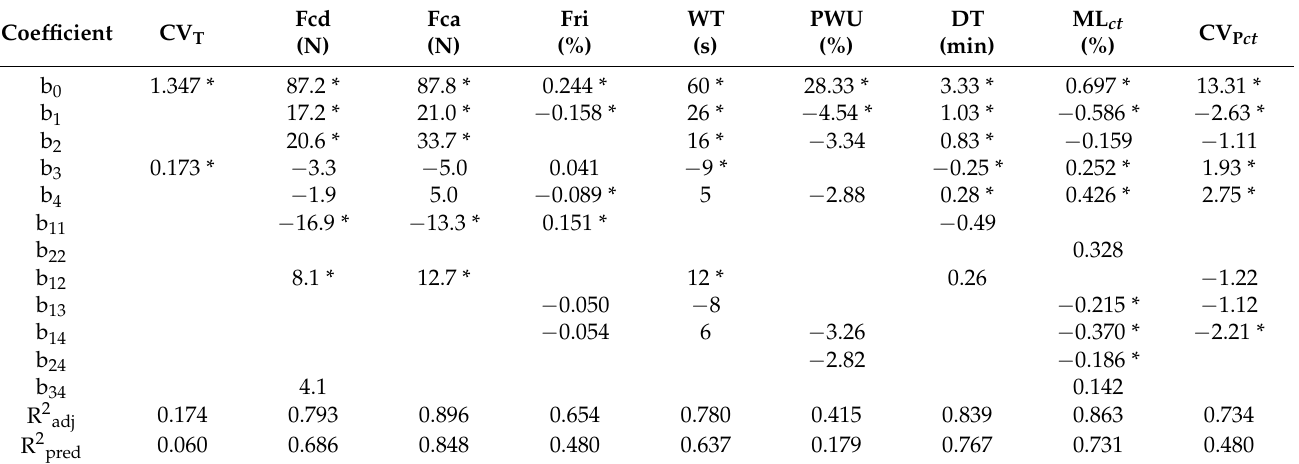
Table 5. Regression coefficients of mathematical models (Equation (1)) of each response and relevant correlation coefficients. CV T , coefficient of variation of tablet mass; Fcd, diametral crushing strength; Fca, axial crushing strength; Fri, tablet friability; WT, wetting time; PWU, percentage water uptake; DT, tablet disintegration time; ML ct , mass loss following splitting into four portions; CV P ct , coefficient of variation of portion